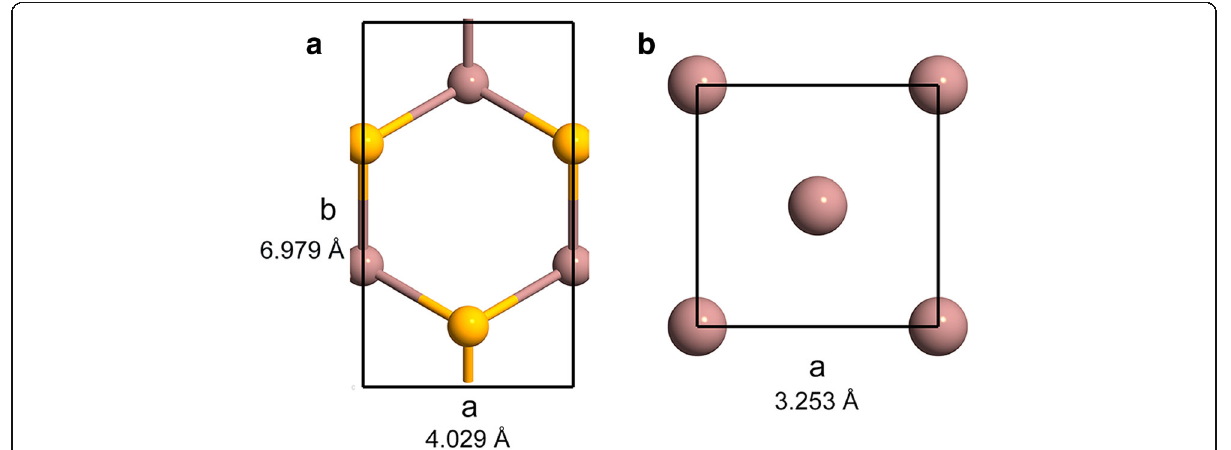
Fig. 1 Top view of unit cell for InSe ( a ) and indium ( b ),